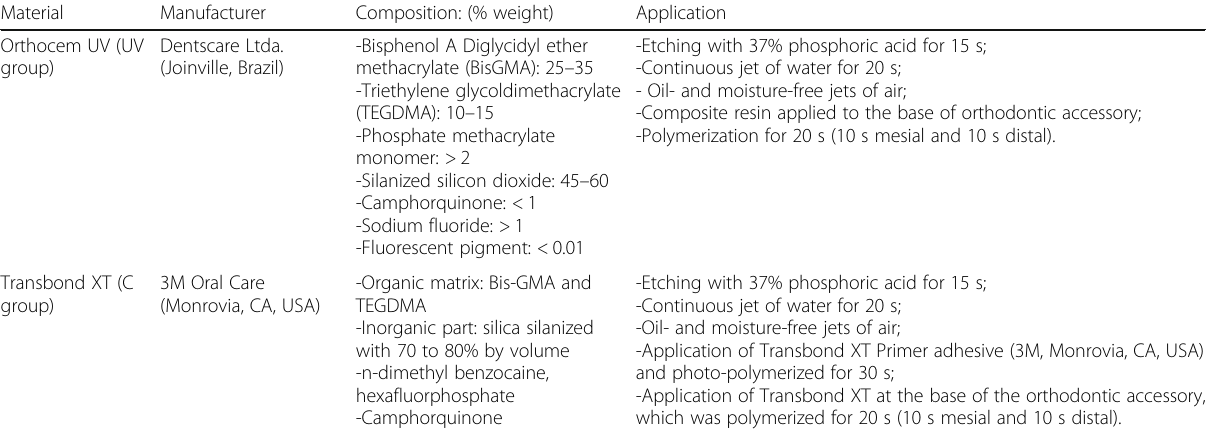
Table 1 Composition of the resins investigated